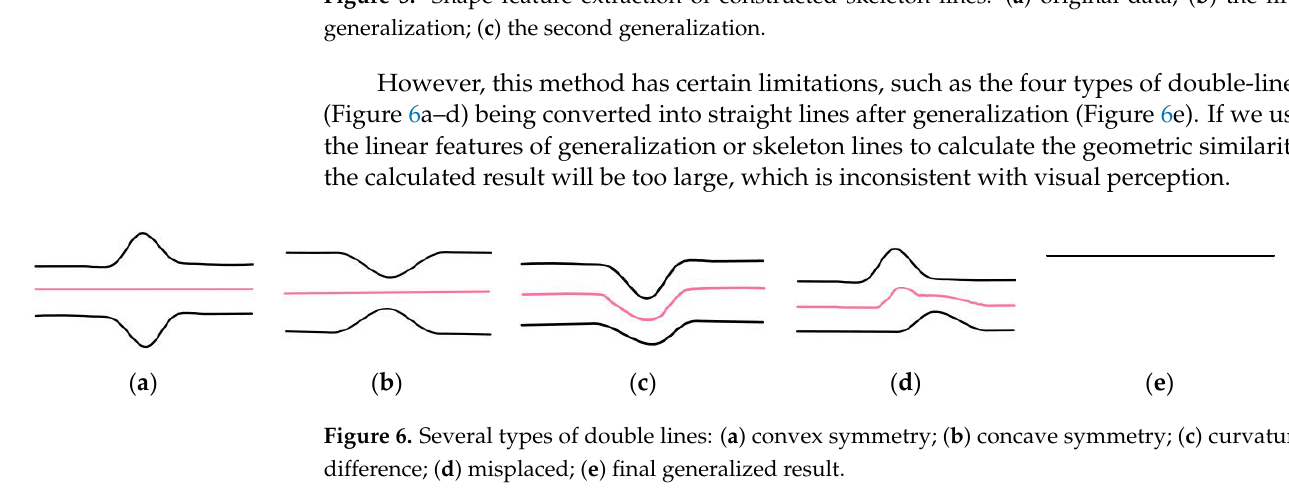
where C (cid:24)(cid:23) represents the upper and lower curves, and Sim geometric between A and B